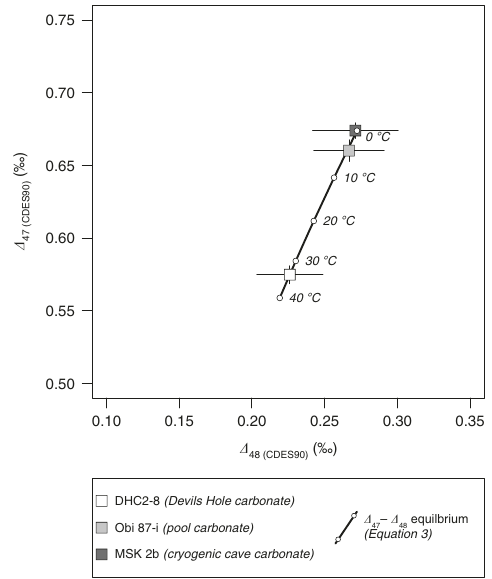
Fig. 1 The equilibrium relationship between carbonate Δ 47 (CDES90) and Δ 48 (CDES90) values. The estimated equilibrium relationship is obtained by combining the empirical Δ 47 (CDES90) vs temperature and Δ 48 (CDES90) vs temperature relationships after anchoring each to the measured isotopic composition of the Devils Hole carbonate (Eqs. (1 – 3); see text for details). The fact that the mean Δ 47 (CDES90) and Δ 48 (CDES90) values of the pool carbonate and the cryogenic carbonate samples, both of which are thought to form very close to isotopic equilibrium (see “ Methods ” and Supplementary Fig. 1), fall within ±0.001 ‰ of the expected equilibrium values con fi rm the robustness of our equilibrium